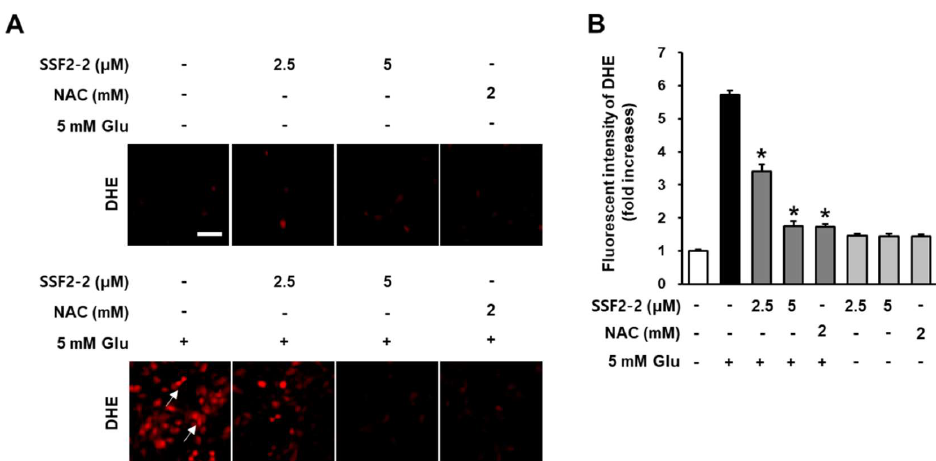
Figure 4. Effects of SSF2-2 on glutamate-induced increases in superoxide anion production. HT22 cells were incubated for 24 h with 5 mM glutamate (Glu) with or without SSF2-2 and N-acetylcysteine (NAC), and then stained with dihydroethidine (DHE). ( A ) Fluorescent images were collected using a fluorescent microscope; ( B ) Fold increases in fluorescent intensity of DHE. White scale bar, 40 µ m. Data represent the mean ± S.E.M., n = 3, * p < 0.05 compared with the glutamate-treated group.